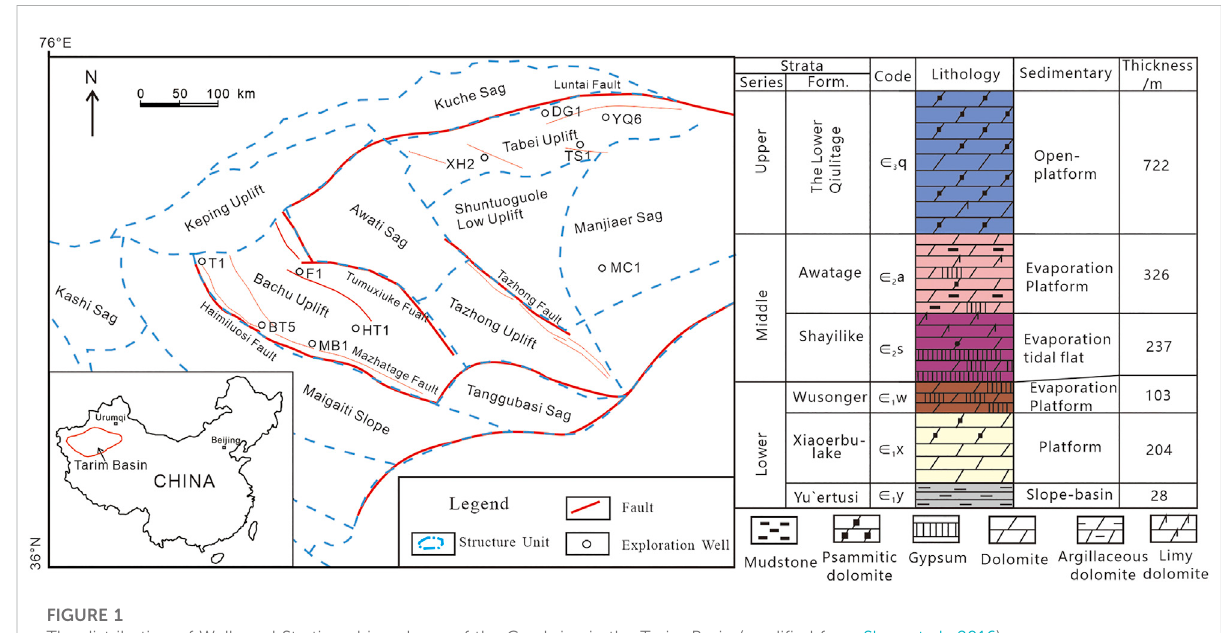
FIGURE 1 The distribution of Wells and Stratigraphic column of the Cambrian in the Tarim Basin (modi fi ed from Shen et al., 2016).